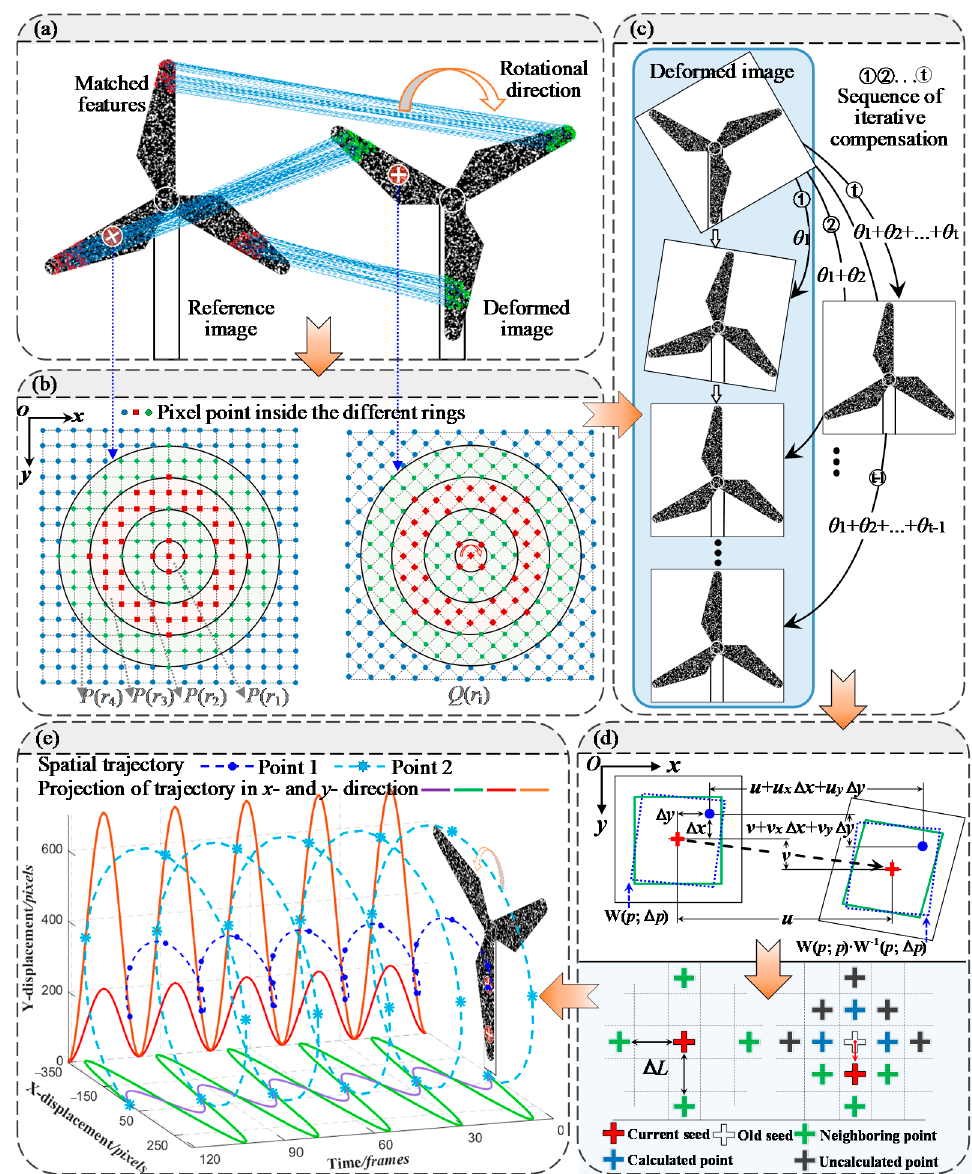
Figure 1. Framework of the proposed AC-SURF algorithm: ( a ) Feature matching using SURF; ( b ) Evaluation criteria using ring template; ( c ) Angle compensation; ( d ) Deformation estimation using DIC; ( e ) Multipoint tracking.